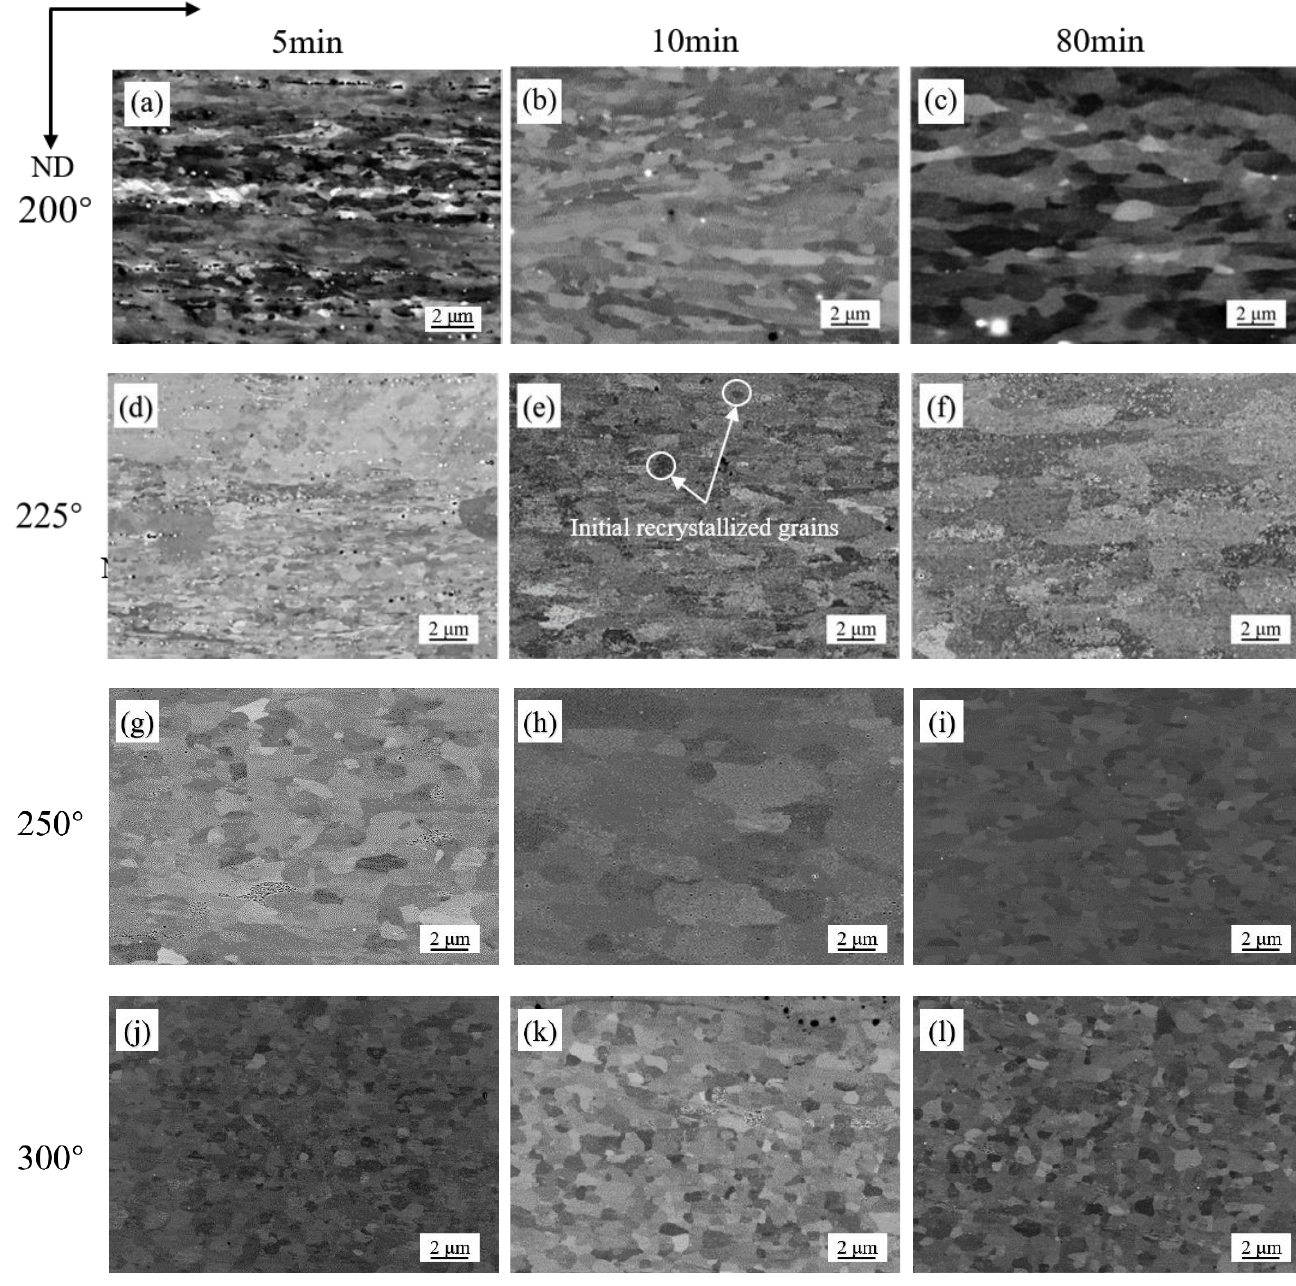
Figure 4. Microstructures of cold-rolled Al-0.5%Cu after annealing in RH: ( a ) 200 °C, 5 min; ( b ) 200 °C, 10 min; ( c ) 200 °C, 80 min; ( d ) 225 °C, 5 min; ( e ) 225 °C, 10 min; ( f ) 225 °C, 80 min; ( g ) 250 °C, 5 min; ( h ) 250 °C, 10 min; ( i ) 250 °C, 80 min; ( j ) 300 °C, 5 min; ( k ) 300 °C, 10 min; ( l ) 300 °C, 80 min.